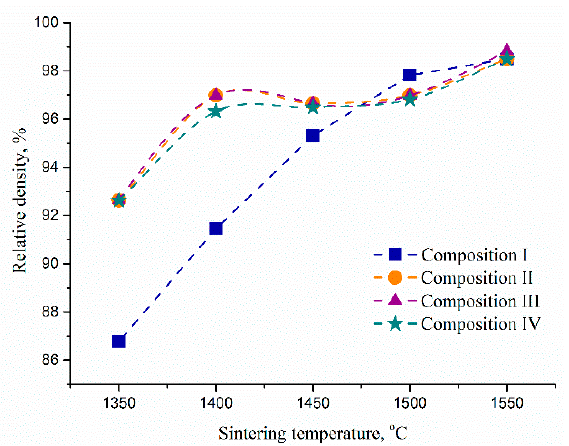
Figure 10. The influence of Co additive on relative density of 3Y-TZP-Al 2 O 3 sintered at different